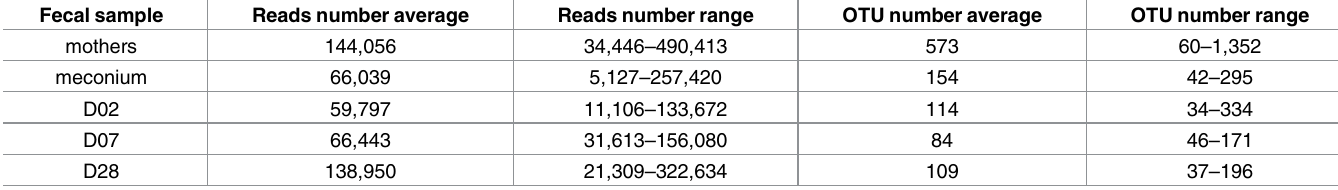
OTU: Operational Taxonomic